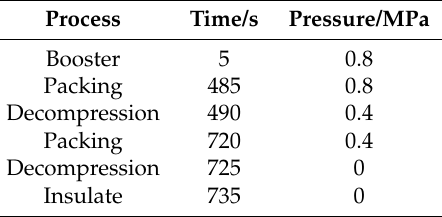
Table1. Hot ‐ pressing processes.